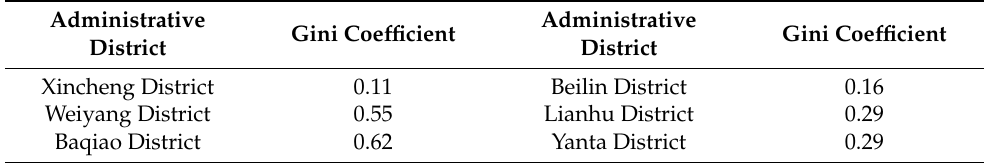
Figure 10. Lorenz curve and Gini coefficient of medical facilities. Table 3. Gini coefficient of accessibility of medical facilities in each district.